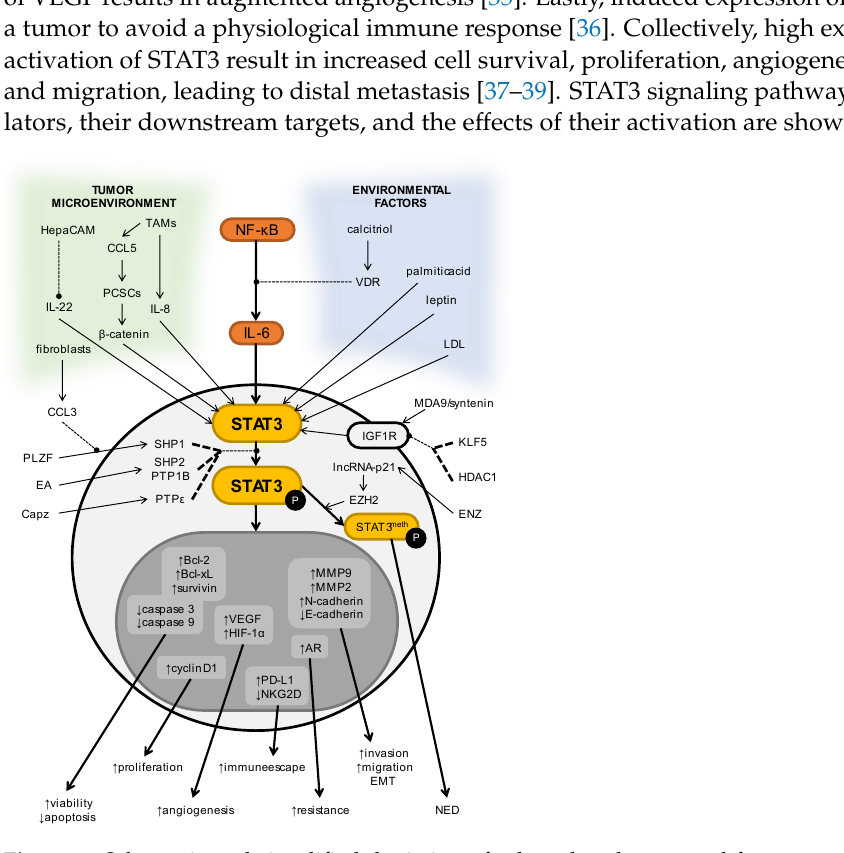
Figure 2. Schematic and simplified depiction of selected pathways and factors regulating STAT3 expression, counting its downstream target proteins, with the consequences of their overexpression in prostate cancer. Dashed lines ending with a dot show inhibition; arrows show stimulation.